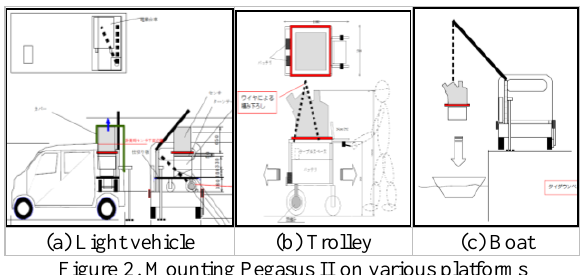
Figure 2. Mounting Pegasus II on various platforms